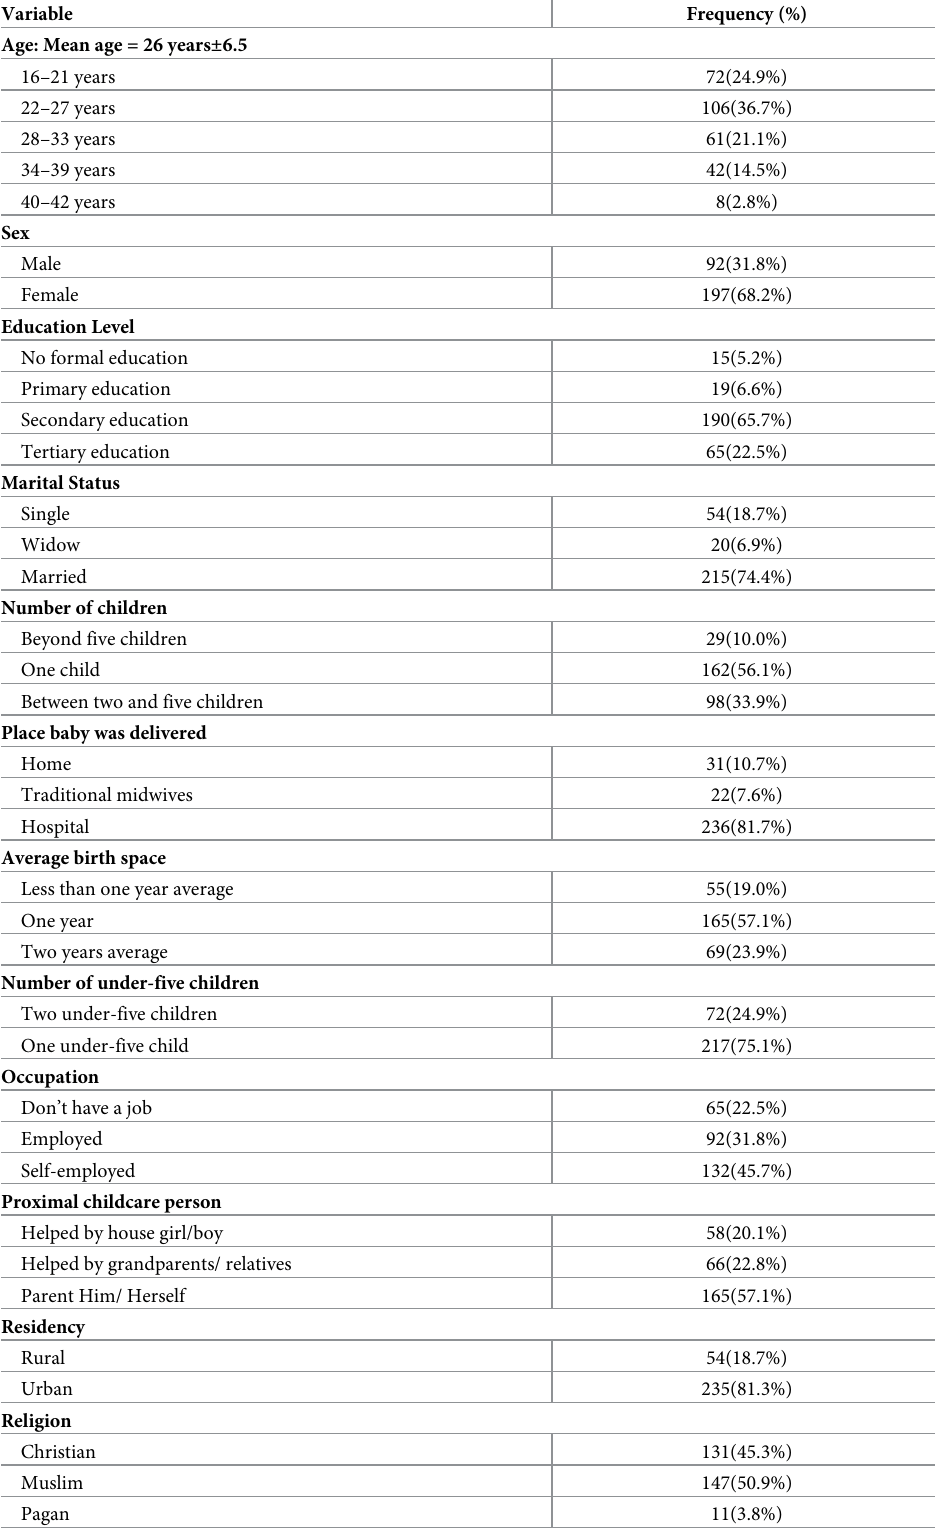
Table 1. Sociodemographic characteristics profiles of caregivers (n =